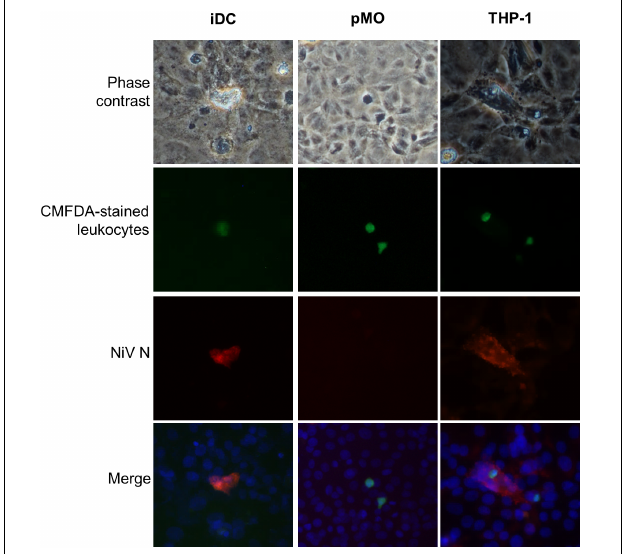
FIGURE 5 | Representative images of migrated iDC, pMO, and THP-1 overlaid on Vero cell monolayer. The CMFDA dye-stained migrated NiV-infected leukocytes (green) were overlaid on Vero cells and immunostained after 24 h by incubating with polyclonal anti-NiV N and Alexa Fluor R (cid:13) 564-conjugated secondary antibody (red). Cell nuclei were counterstained with Hoechst 33324 (blue). Magnification at 200 ×